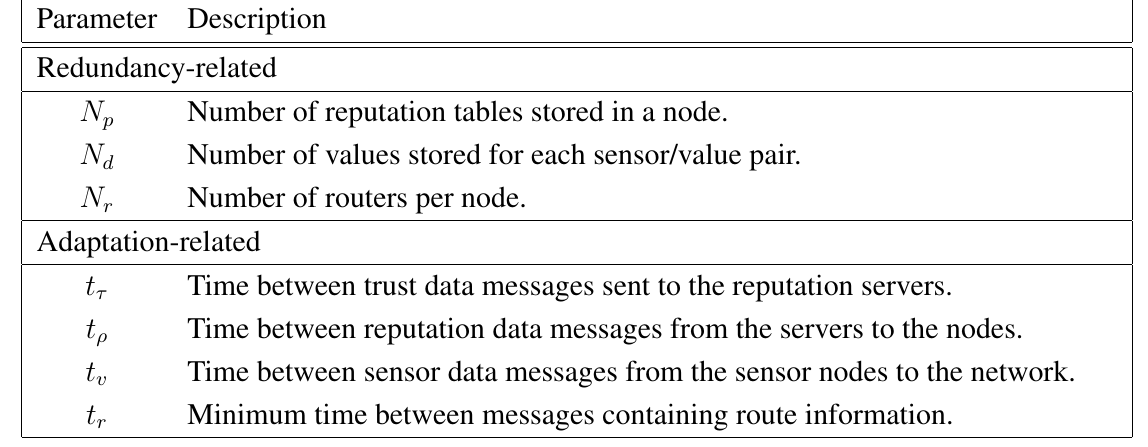
Table 1. Parameters that can be adjusted dynamically to adapt the environment to possible